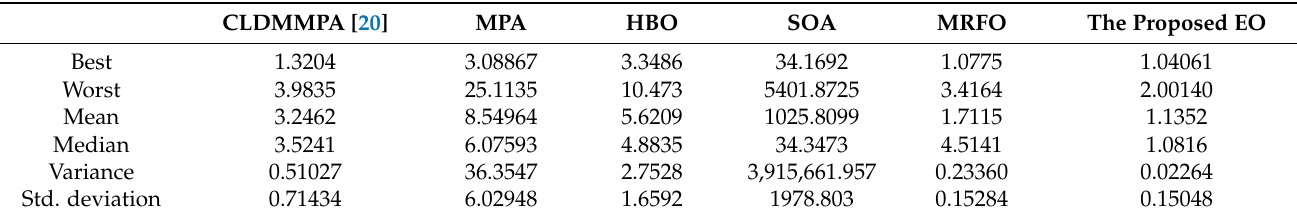
Table 8. Statistical parameters (best, worst, mean, median, variance, and standard deviation) of all optimizers used for dynamic-state SOFC